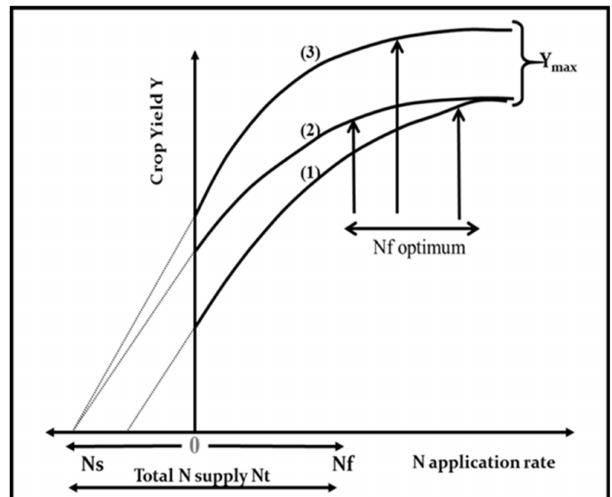
Figure 1. Representation of di ff erences among the response of crop yield (Y) to N fertilizer application rates (N f ) according to variations in (1) soil N supply (Ns), (2) yield without external N application, and (3) maximum yield (Y max ). All these variations lead to di ff erences in optimum N fertilizer application rate. Note: the Nf optimum is arbitrarily placed at the onset of the plateau region for the yield-to-N-supply response